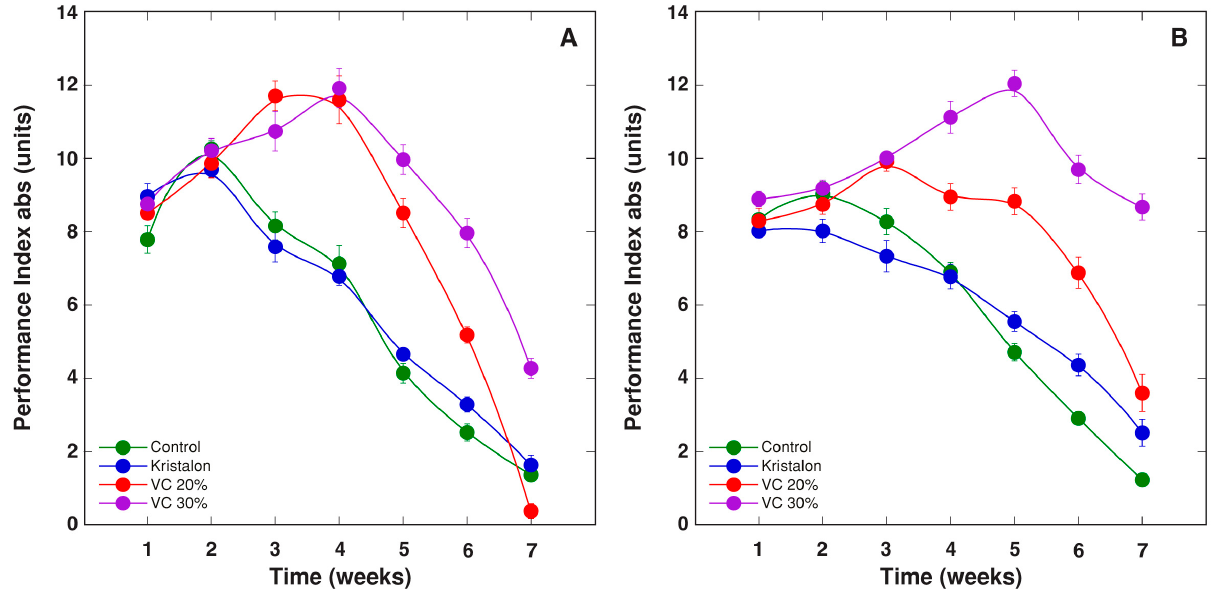
Figure 12. Changes of chlorophyll a fluorescence parameter PI abs , as affected by mineral fertilizer (Kristalon) and amendment with vermicompost (VC) at a 20% and 30% ( v / v ) rate in Dracocephalum moldavica plants grown in peat substrate ( A ) or commercial garden soil ( B ). Results are means ± SE from five replicates for each treatment, three measurements per replicate.